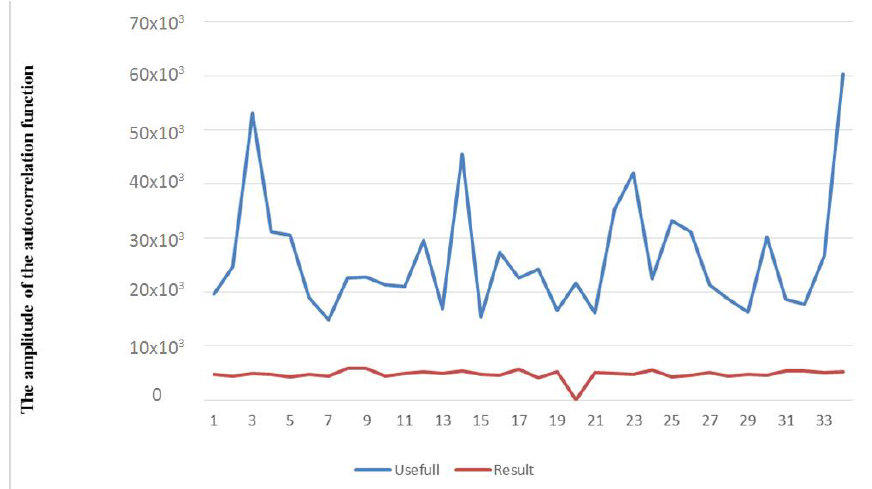
Figure 7. The amplitude of the autocorrelation function of the legitimate traffic components (blue color) and the total traffic components (red color) in the third iteration.